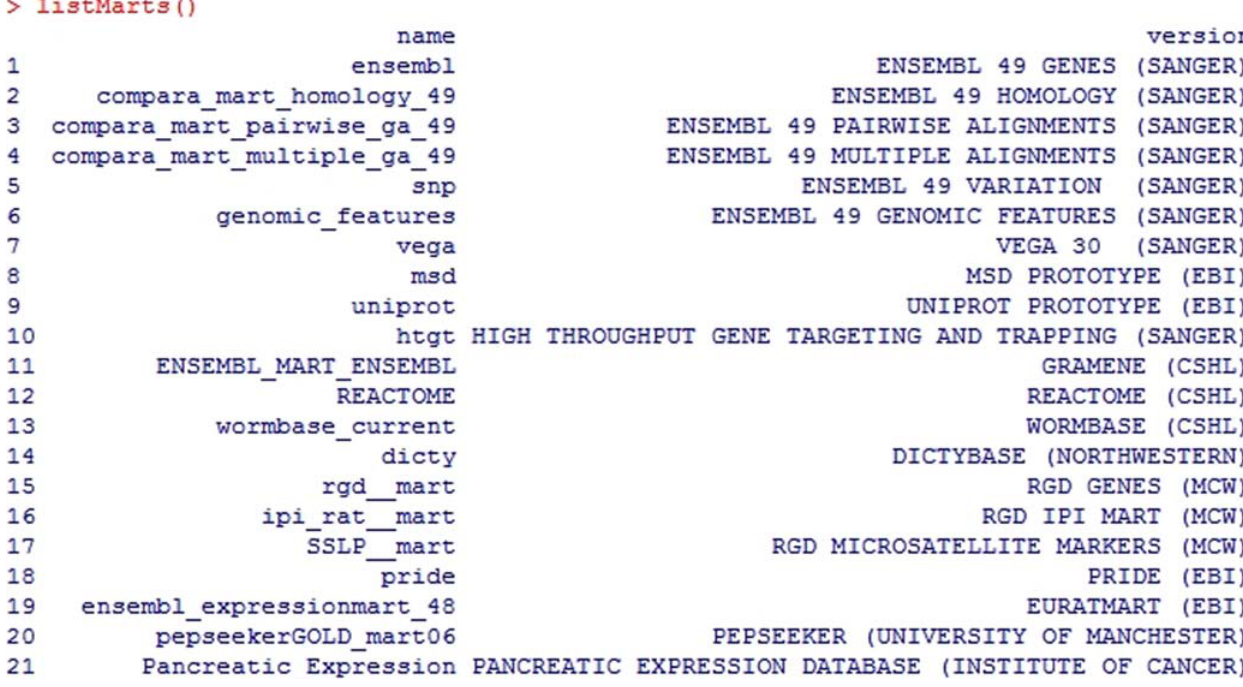
Figure 3. BioMart libraries available in the Central Server.